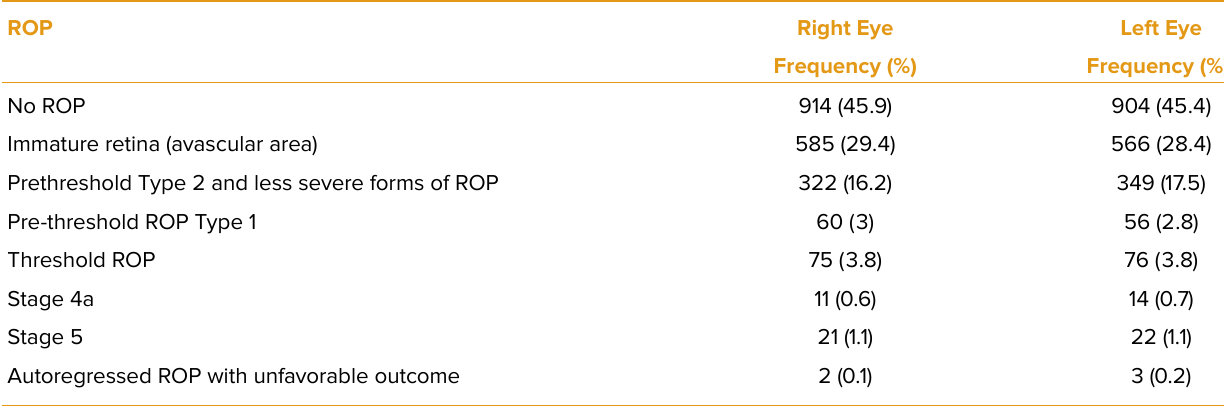
Table 1. The rate and stage of ROP in infants with gestational age equal or less than 37 weeks ROP